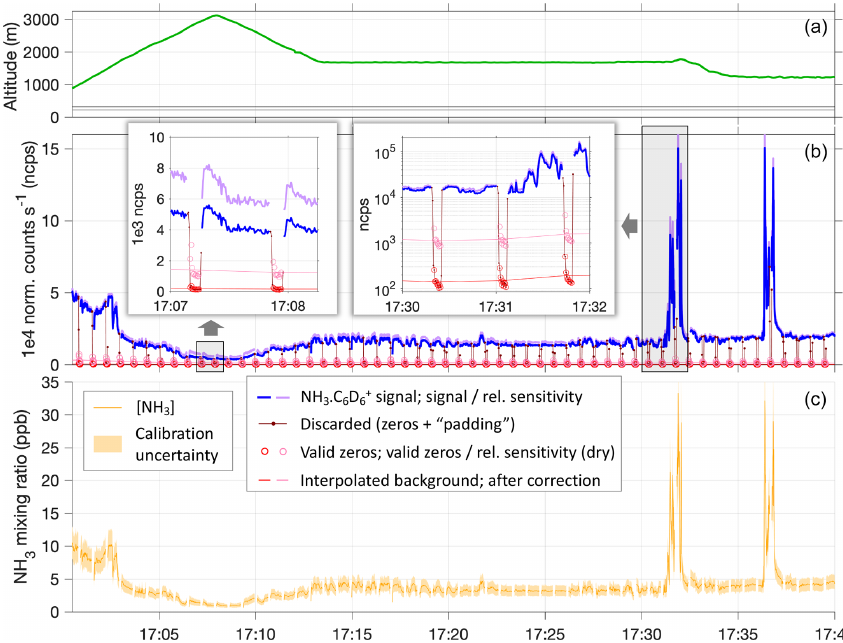
Figure 4. Example time series showing instrument time response to NH 3 in plumes and instrument zeros, based on a segment of RF6 on 3 May. Panel (a) shows the flown altitude profile in meters above mean sea level; horizontal lines mark the elevations of the SGP ground site (dark gray) and KBVO airport (light gray). Panel (b) shows normalized count rates of NH 3 · C 6 D + (blue, in-flight zeros in red). Sensitivities 6 as per calibration results were applied (cf. Fig. 2), including consideration of their humidity dependence (pink and purple). Insets highlight the response to plumes of high NH 3 levels, to measurements in the much cleaner and drier free troposphere, and the respective in-flight zero measurements. Background signals were interpolated between zero measurements (red and pink lines) and subtracted from the ambient signals to obtain ambient NH 3 mixing ratios (c) . The sensitivity values used here range from 2.8 to 4.2ncpspptv − 1 , with a general uncertainty of ± 1ncpspptv − 1 estimated based on the calibration tests (indicated by shadings in panel c